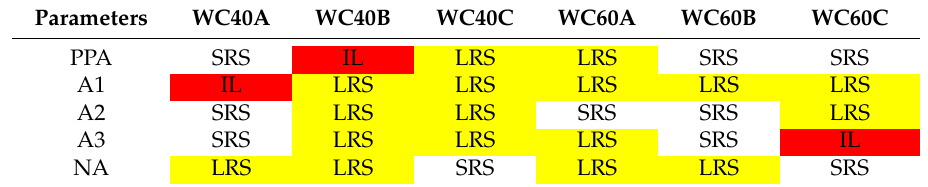
Table 5. Classification of sensitivity for all parameters simulated from optimum ANN models. Parameters